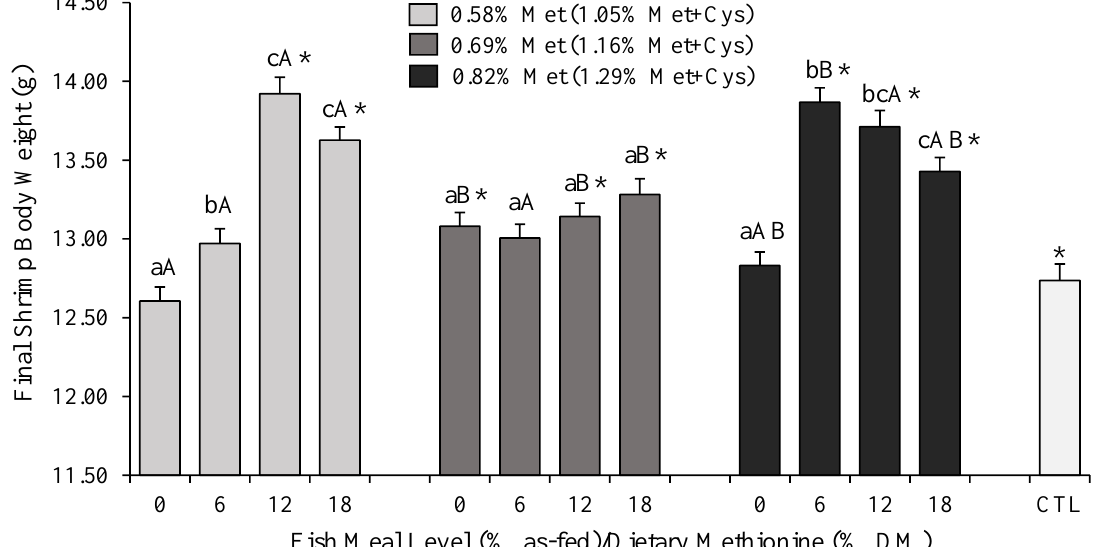
Figure 1. Mean ( ± standard error) body weight (g) of L. vannamei after 70 days of rearing in green water tanks of 1 m 3 . Different lowercase letters indicate statistically significant differences between fish meal (FML) levels within the same dietary methionine (Met) content at the α = 0.05 level according to Tukey’s HSD. Different capital letters refer to significant differences ( p < 0.05) between Met levels within each FML dietary inclusion. Asterisks (*) indicate statistically significant differences between the commercial reference (CTL) and the experimental diets ( p < 0.05, Student’s t -test).